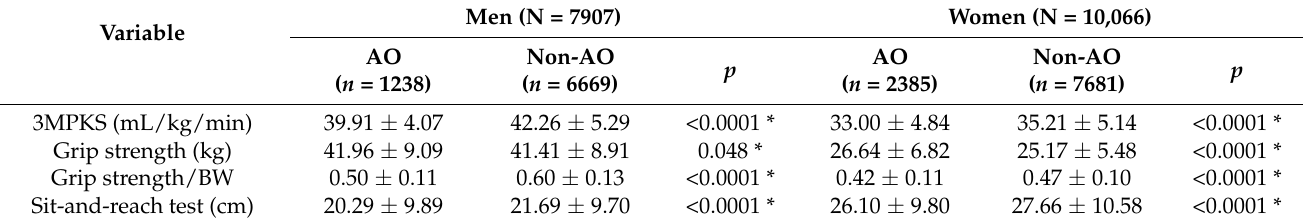
Table 2. Health-related physical fitness measurements according to the abdominal obesity status.